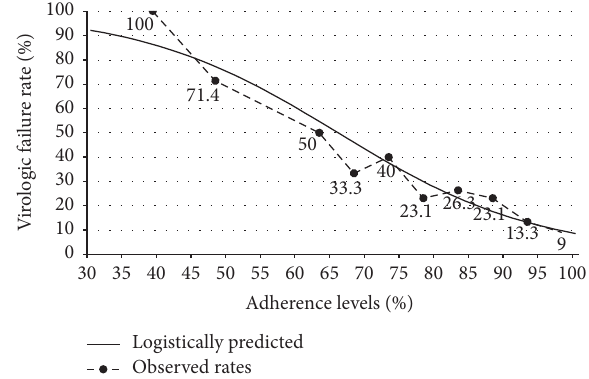
Figure 1: Observed and model-predicted virologic failure rates by adherence levels. The observed rates were calculated at specific adherence level categories, while the predicted rates were estimated across the continuous range of